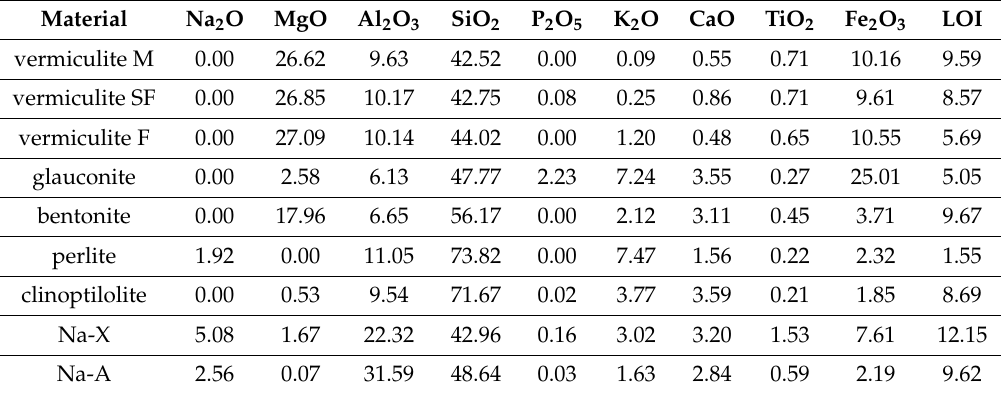
Table 1. Chemical composition of the adsorbents assayed by a quantitative X-ray fluorescence spectrometry